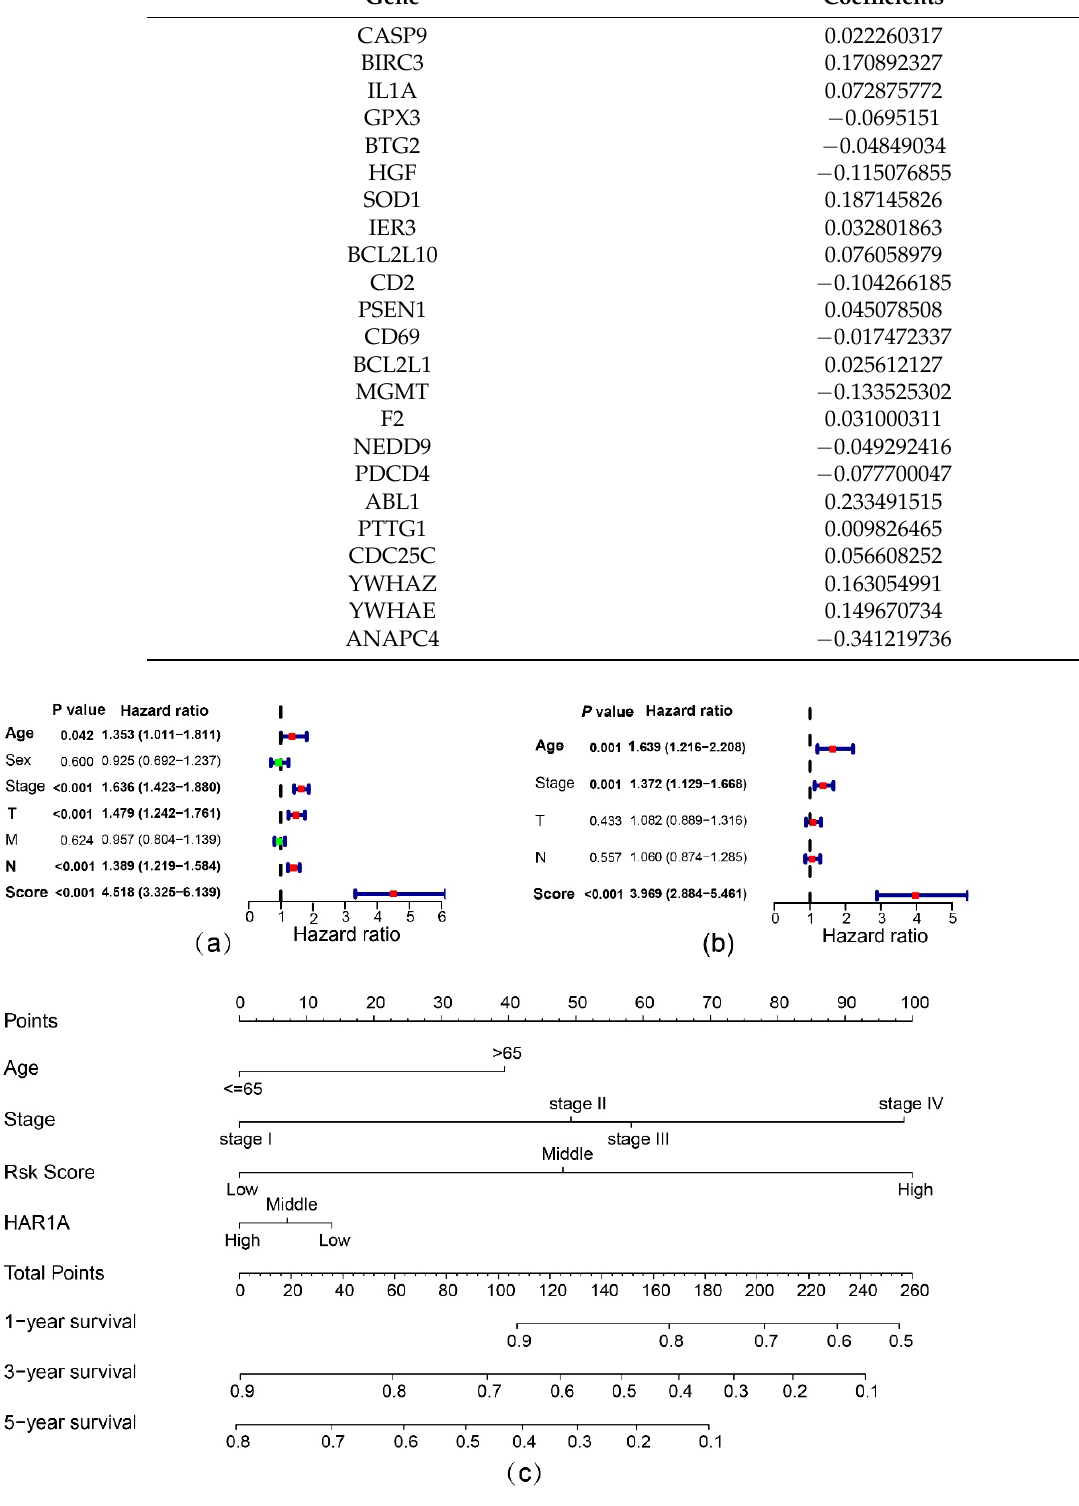
Table 1. Coefficients of genes in the risk signature.